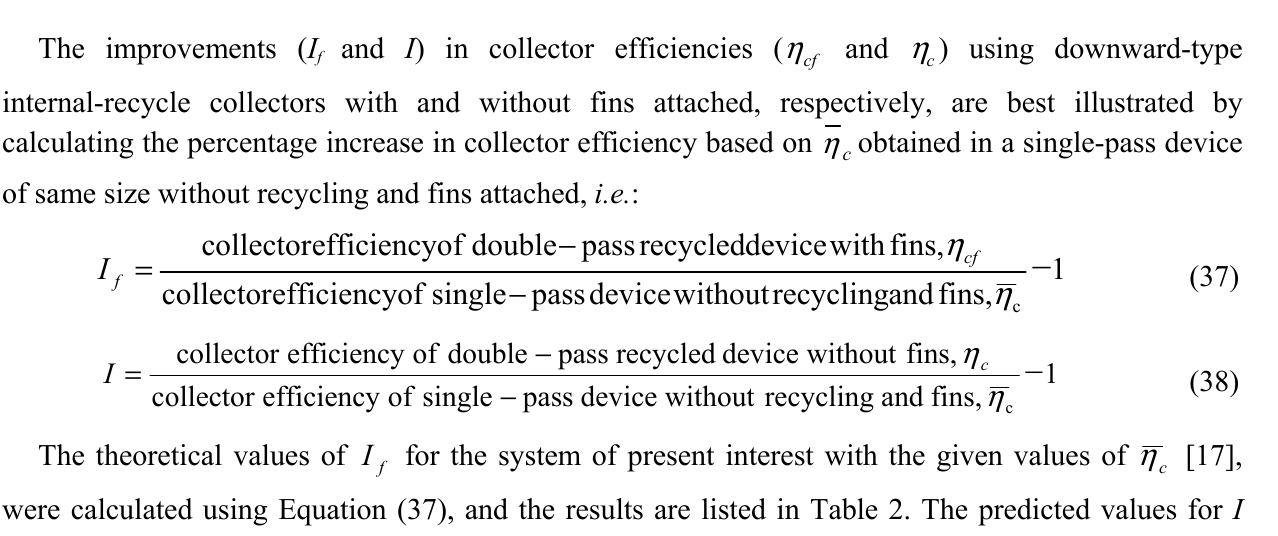
Figure 5. Collector efficiency ( 298K =